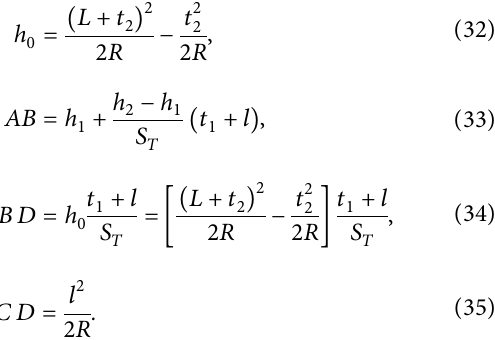
T ). Figure 9: Sight distance under an overpass ( L ＜ S